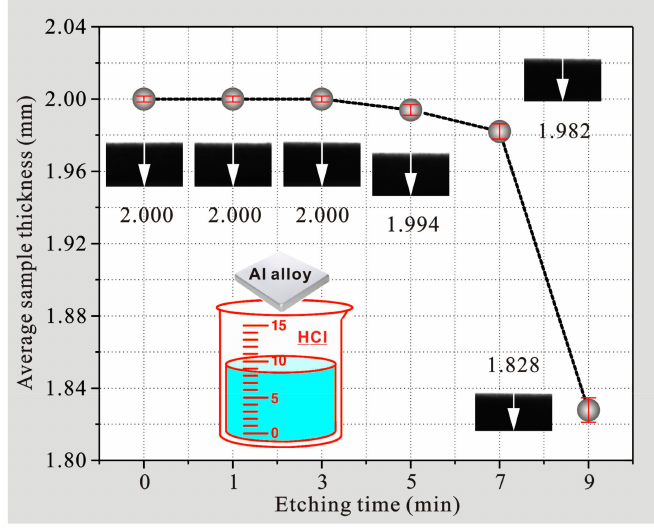
Figure 3. Sample thicknesses of 7075 aluminum alloys after etching for various times.